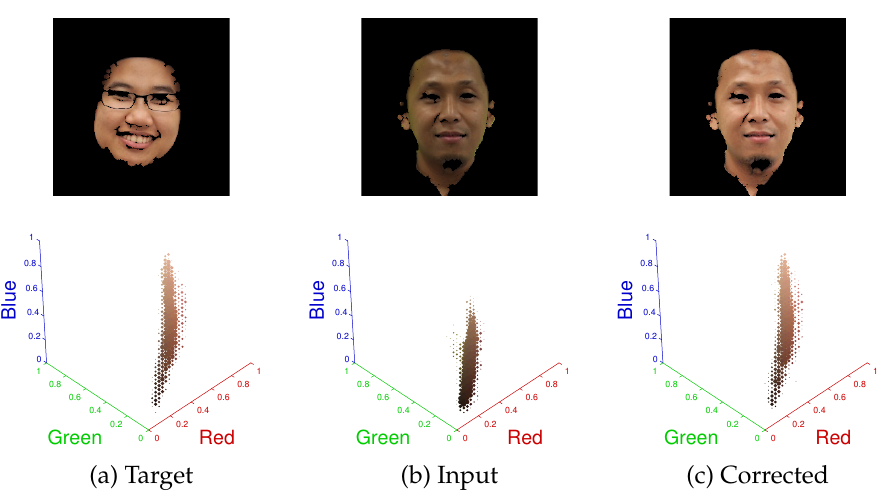
Figure 4. Each extracted facial skin color region and their distributions. The top row shows ( a ) target color image; ( b ) input image; and ( c ) color graded image. The bottom row shows their color distributions in the RGB color space.